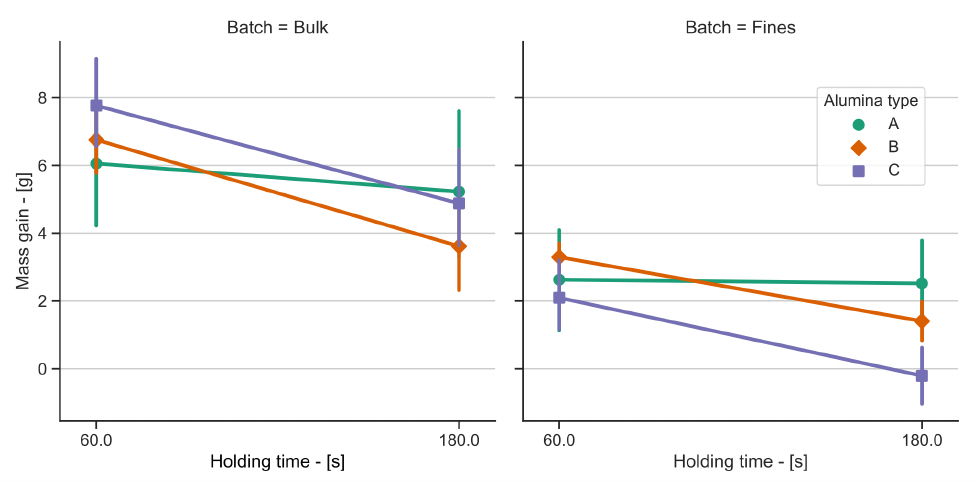
Figure 4. Mean mass gain of rafts, given as the difference between raft weight and mass alumina added, for bulk ( left ) and fines ( right ) of the three alumina types A, B and C. The error bars indicate the 95% confidence